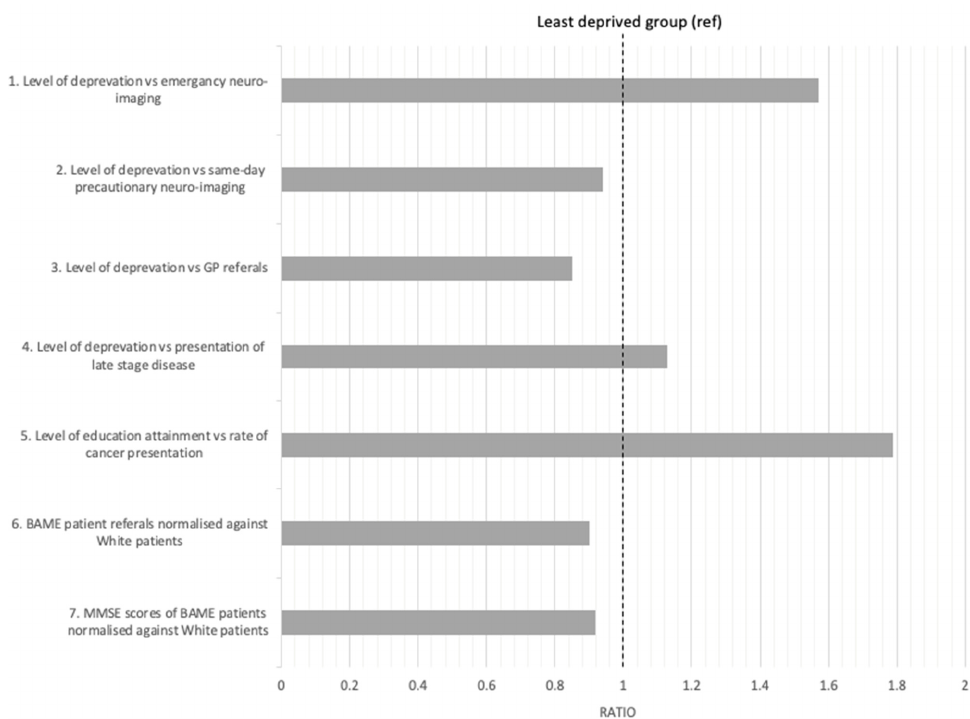
Figure 3. Analysis of some exemplar studies indicating the relationship between social deprivation factors and health care service provisions. (1) Level of deprivation measured in Townsend scores in North England for emergency CT neuroimaging [39]. Least deprived ( n = 4078) is in the highest quantile and most deprived ( n = 6395) is in the lowest quantile. A score above 1 highlights more patients in deprived areas accessing neuroimaging for head traumas. It is suggested the increased need is due to socio-economic factors such as risk-associated behaviours and manual labour occupations [39]. (2) High levels of deprivation measured by Carstair scores result in less precautionary same-day CT or MRI imaging of patients admitted with stroke management in English public hospitals [14]. The total number of scans in 2008/09 was 25452). A score below 1 indicates that fewer precautionary CT and MRI scans are taken for patients in lower quartiles of socio-economic deprivation at request of health care professionals. (3) High levels of deprivation measured in IMD scale indicate fewer numbers of referred cases of dementia by GP practices, taking Stockport ( n = 293,594) and Manchester ( n = 531,153) as examples of the least and most deprived regions in the area, respectively [34]. A score below 1 indicates an underdiagnosis of dementia patients in more deprived areas. (4) Level of deprivation specified by the Index of Multiple Deprivation’s (IMD) 2004 ranking against the patients presenting with late stage oral cancer in Liverpool [15] (most deprived ( n = 351/711) against least deprived ( n = 310/711)). A score above 1 indicates that more patients in the least deprived areas have a delayed diagnosis of oral cancer. (5) Level of education attainment as an index of socio-economic status is inversely proportional to cases of upper aerodigestive tract cancer in Glasgow, Manchester and Newcastle ( n = 322) [43]. A score above 1 indicates how groups with a lower education attainment have higher rates of cancer presentation. (6) GP referrals of BAME patients to Memory Assessment Services (MAS) for dementia against White patients in London ( n = 628,730) [37]. BAME patients are more socio-economically deprived and, therefore, this is a measure against White patients, who are representative of less deprived groups [56]. A score below 1 indicates an underrepresentation of BAME at MAS clinics due to the lack of referrals to access specialist diagnostic services. (7) Diagnostic Mini Mental State Examination scores as a measure of dementia progression at the time of diagnosis in BAME patients against White British patients in London ( n = 13,233) [33]. A score below 1 indicates a delayed referral to MAS compared to White patients. Delayed referral highlights an inequality that may be due to delayed help-seeking behaviours in ethnic minority communities